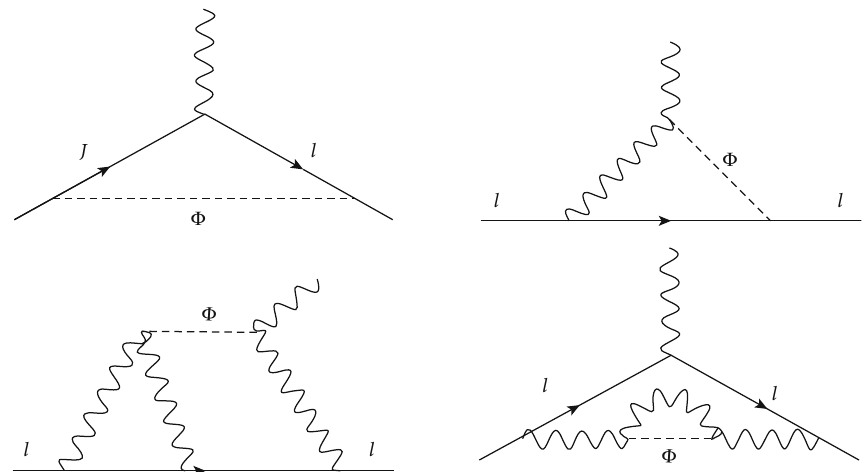
Figure 1: LO (top left diagram) and NLO scalar/pseudoscalar contributions to the lepton anomalous magnetic